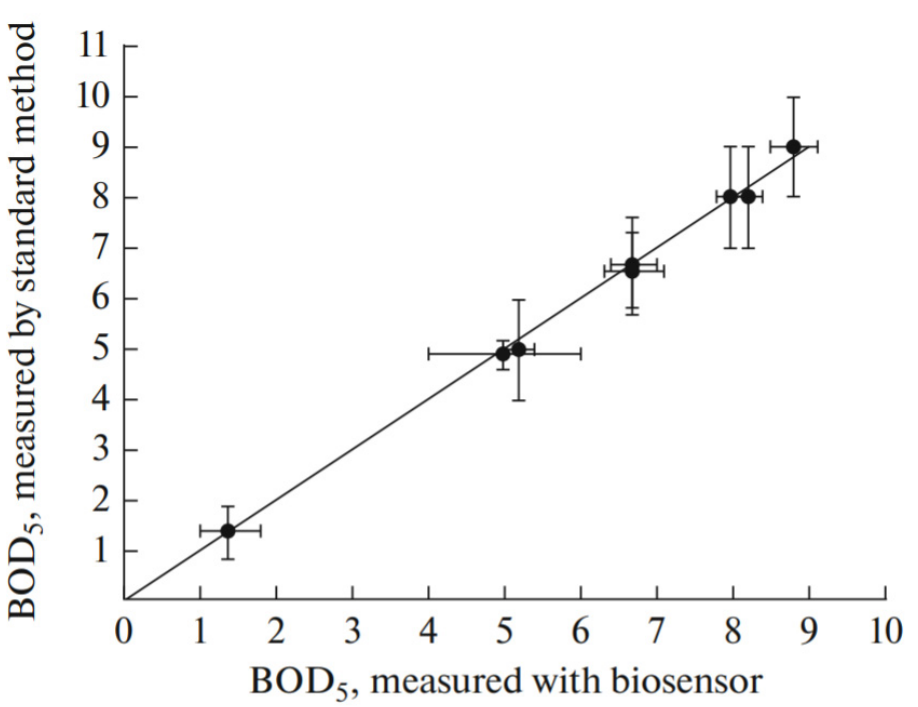
Figure 11. Correlation of biosensor BOD measurements with those carried out by the standard method. Reprinted with permission from [102].